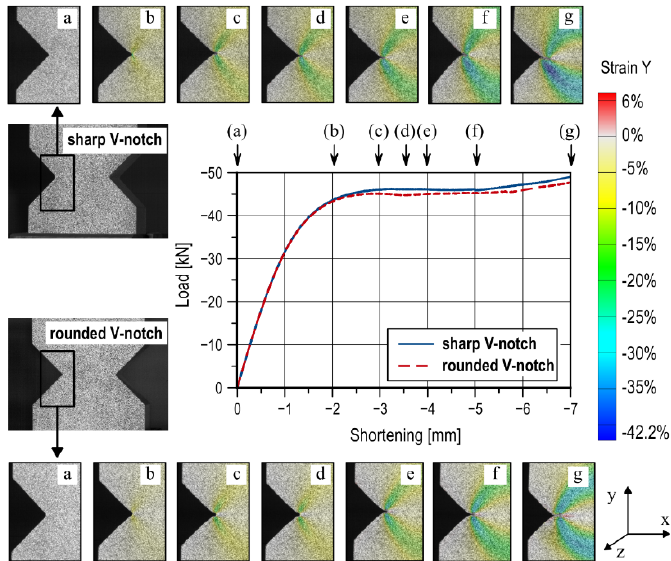
Figure 5. The process of notches closing in specimens of thickness t 2 at a strain rate of 4 × 10 −3 s −1